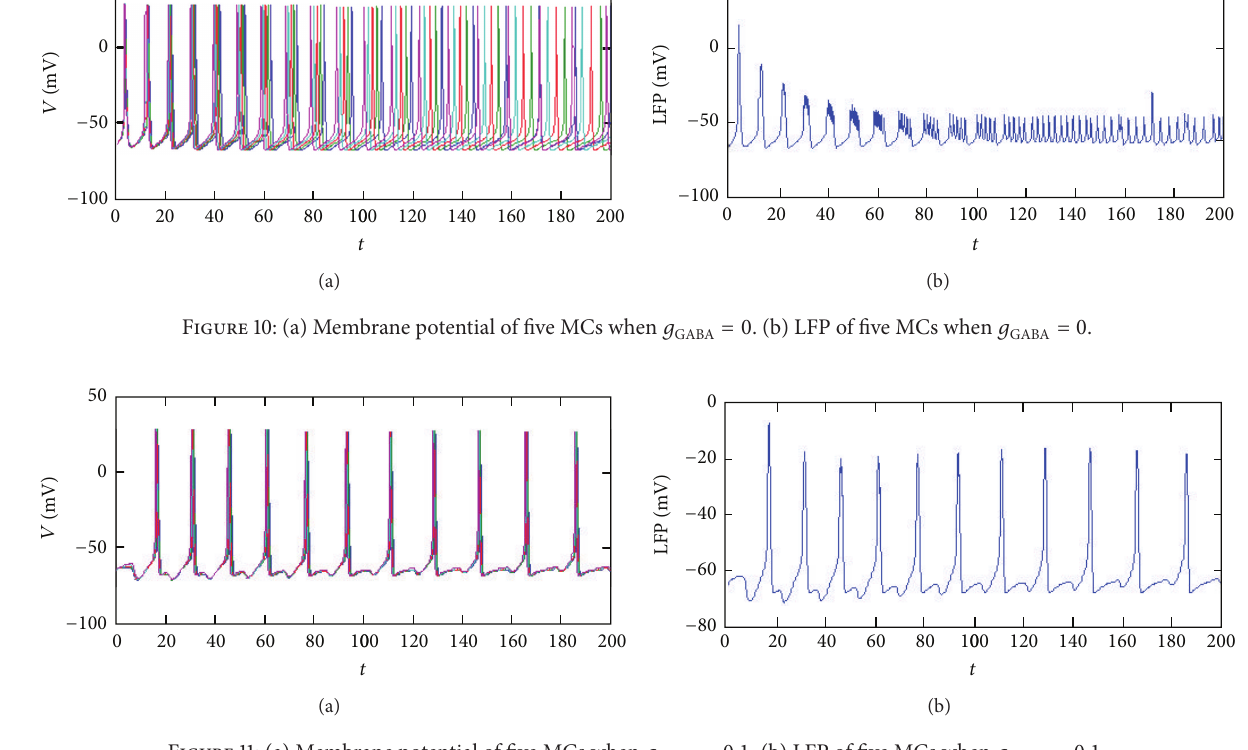
Figure 11: (a) Membrane potential of five MCs when 𝑔